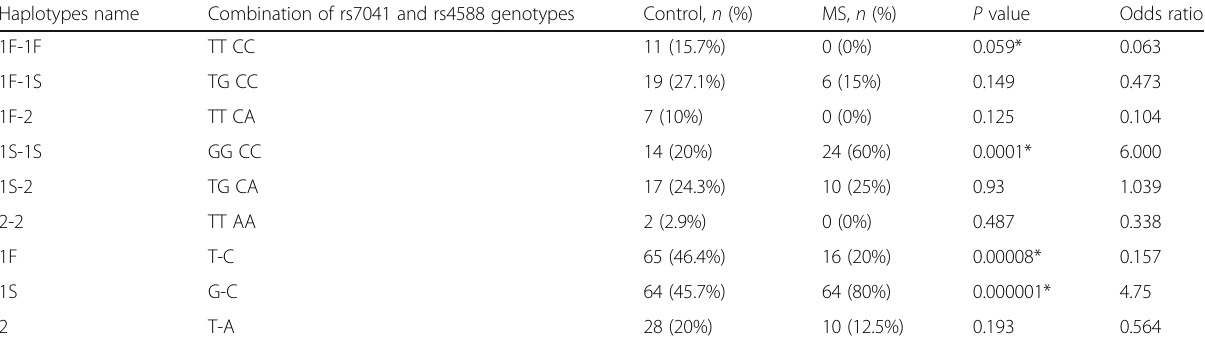
Table 2 Distribution of the compound genotypes for the two DBP gene variations Haplotypes